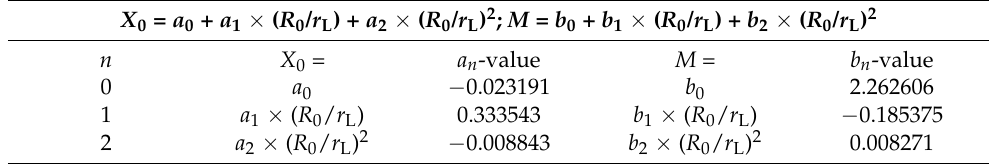
Table 2. X 0 and M as second-degree polynomial functions of R 0 / r L .